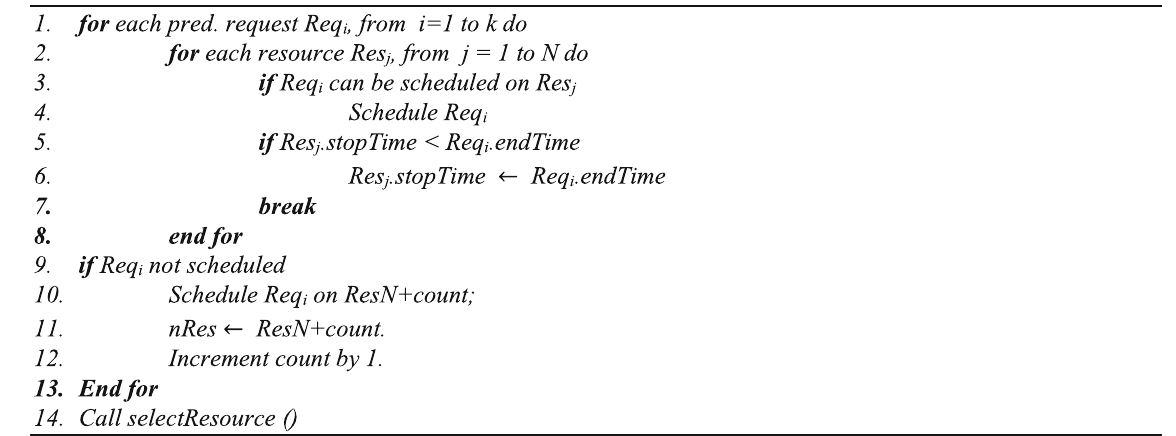
Table 2 Proactive Auto-Scaling Algorithm (Part